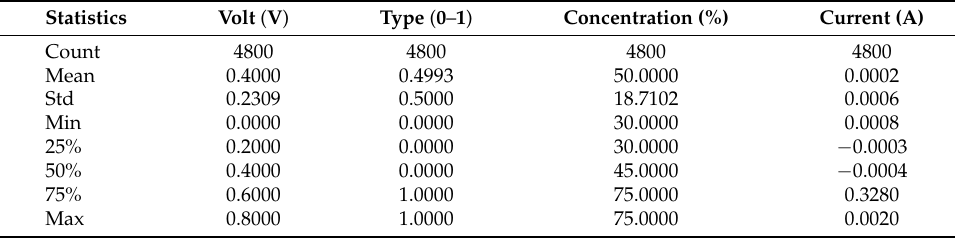
Table 2. Important statistical values of Dataset B.